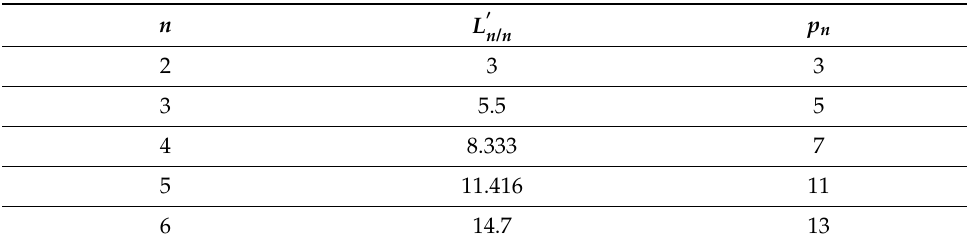
Table 1. FOS average length and primes p n